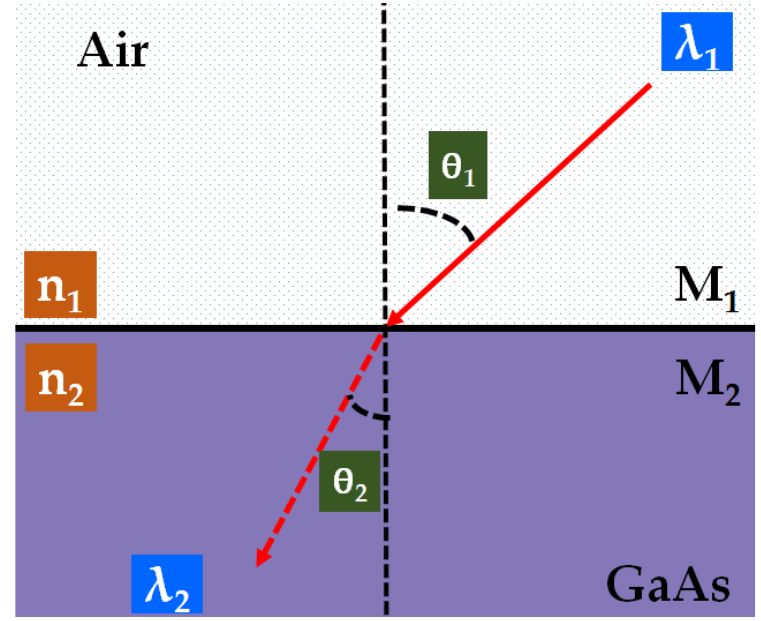
Figure 2. The relationship between the angle of incident and refraction light.